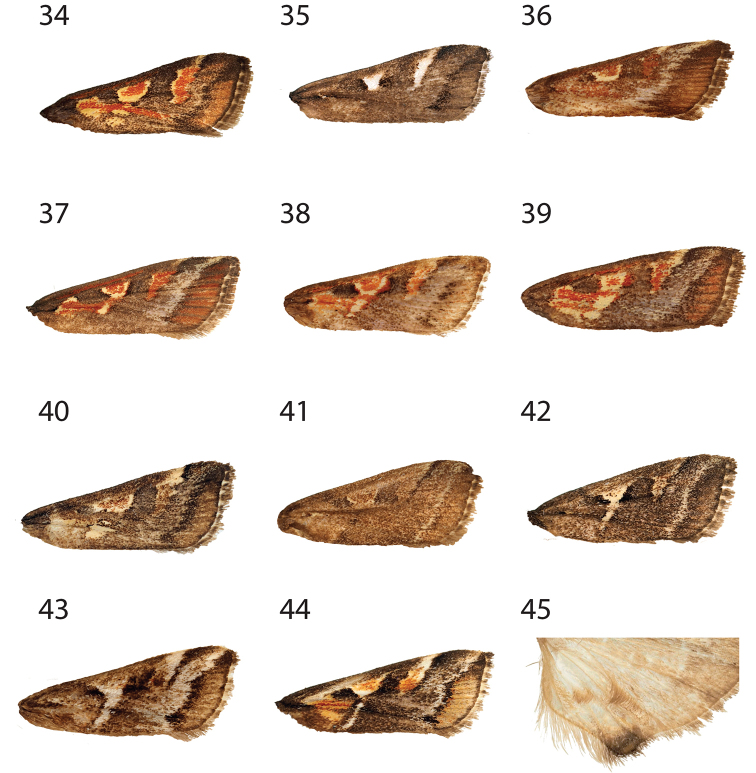
Forewing of Hoploscopa species. 34Hoploscopa
ignitamaculae sp. nov., paratype, ♂, North Sulawesi, Danau Mooat, east of Kotamobagu, 1000 m, 30–31.iii.2000 (A. Kallies & C. Zorn) (genitalia on slide TL509 ♂) 35Hoploscopa
albomaculata sp. nov., paratype, ♀, Indonesia, North Sulawesi, Danau Mooat, east of Kotamobagu, 1000 m, 25–26.iii. 2000, (A. Kallies & C. Zorn) (genitalia on slide TL540 ♀) 36Hoploscopa
sumatrensis sp. nov., holotype, ♂, Indonesia, Sumatra-Holzweg, 25 km SSW-Pematangsiantar, road to Prapat, 6–26.i.1996 (A. Kallies) (genitalia on slide TL755 ♂) 37Hoploscopa
mallyi sp. nov., paratype, ♂, Malaysia, Sabah, Mt Kinabalu, Mesilau, 2000 m, 14–17.xi.2006 (W. Mey & K. Ebert) 38Hoploscopa
gracilis sp. nov., holotype, ♂, Indonesia, Sumatra-Holzweg, 25 km SSW-Pematangsiantar, road to Prapat, 13.ii.1996 (A. Kallies) (genitalia on slide TL754 ♂) 39Hoploscopa
agtuuganonensis sp. nov., holotype, ♀, Philippines, Mindanao, Mt Agtuuganon, 1050 m, 28.v–7.vi.1996 (W. Mey) (genitalia on slide TL616 ♀) 40Hoploscopa
boleta sp. nov., paratype, ♀, Papua New Guinea, Morobe, Mt Kaindi, 2360 m, 3.x.1992 (V. O. Becker) (genitalia on slide TL448 ♀) 41Hoploscopa
pseudometacrossa sp. nov., holotype, ♀, Papua New Guinea, W. Hhl, Prv, near Mt. Hagen, Kuk Ag, Res. Sta., 1600 m, 19–20.viii.1983 (Scott E. & Pamela Miller) (genitalia on slide TL689 ♀) 42Hoploscopa
metacrossa Hampson, ♀, Papua New Guinea, Morobe Province, near Bulolo, Mt Susu National Reserve, Araucaria forest, 975 m, 27–28.viii.1983 (S. Miller). 43Hoploscopa
jubata sp. nov., paratype, ♂, Papua New Guinea, Morobe Province, near Bulolo, Mt Susu National Reserve, Araucaria forest, 975 m, 27–28.viii.1983 (S. Miller) 44Hoploscopa
jubata sp. nov. , paratype, ♀, Morobe Province, near Bulolo, Mt Susu National Reserve, Araucaria forest, 975 m, 27–28.viii.1983 (S. Miller) 45 Hindwing scent organ in Hoploscopa
metacrossa. Paratype, ♂, Papua New Guinea, Morobe Province, Wau, 1200 m, 8–14.xii.1976 (G. F. Hevel & R. E. Dietz) (genitalia on slide TL443 ♂).